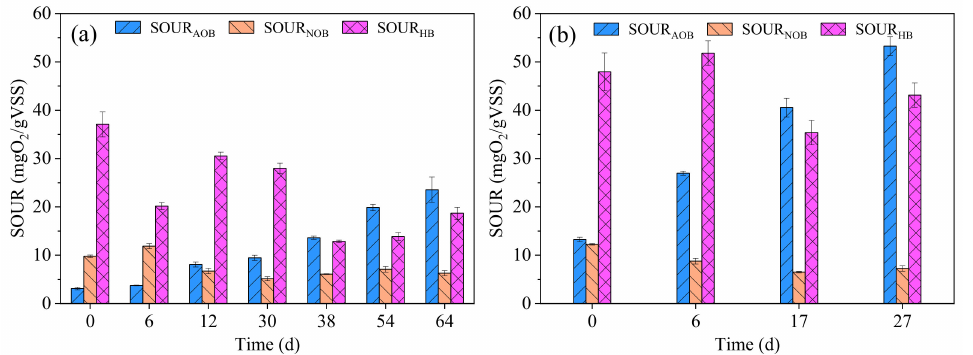
Figure 5. Variations of SOUR AOB , SOUR NOB and SOUR HB in R1 ( a ) and R2 ( b ) throughout the operational